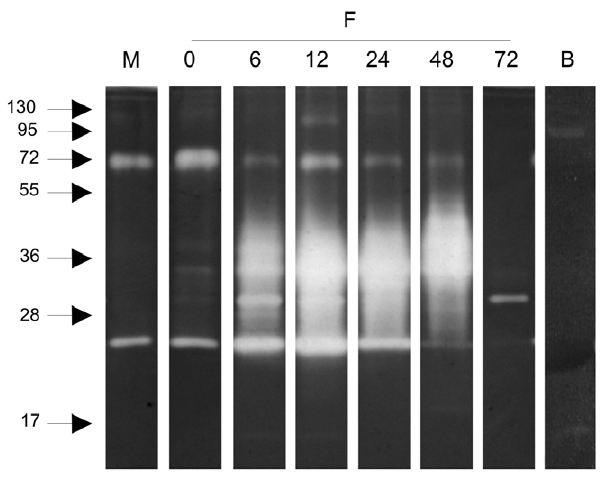
Figure 4. Zymography performed with gelatin co-polymerized gel incubated at pH 8 with samples obtained at different times ABF. M: males, F : females; 0 : sugar-fed females; 6 to 72 : females obtained at 6, 12, 24, 48 and 72 hours ABF; B : 2 m L of hamster blood. Samples corresponding to 1/50 of 1 insect midgut were loaded in lanes M and 0 to 72 . A control sample contained 1/50 of 2 m L of hamster blood. Molecular mass standard values (kDa) are indicated by numbers and arrows on the left side of the figure.